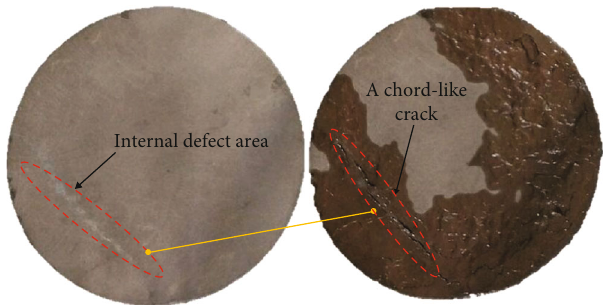
Figure 23: Surface chord cracks of 3# sample.